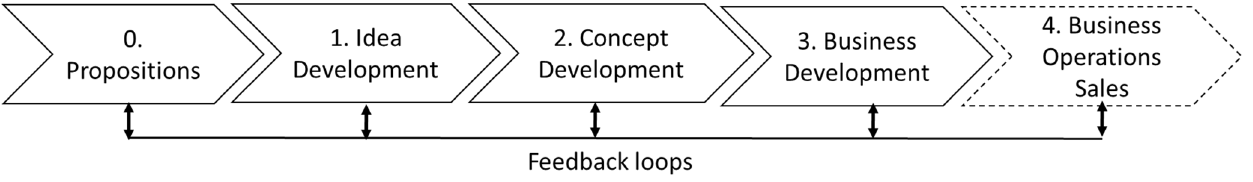
Figure 1. Process chart of a new venture creation and entrepreneurial